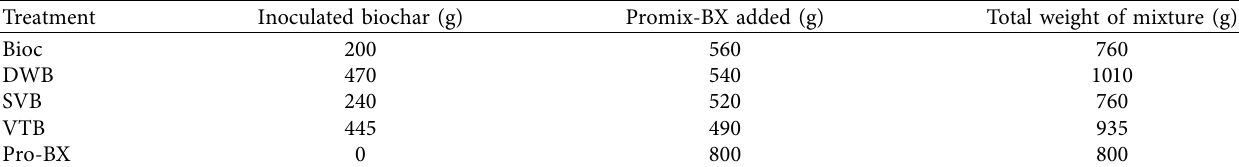
Table 1: Composition of individual vermicast-inoculated biochar